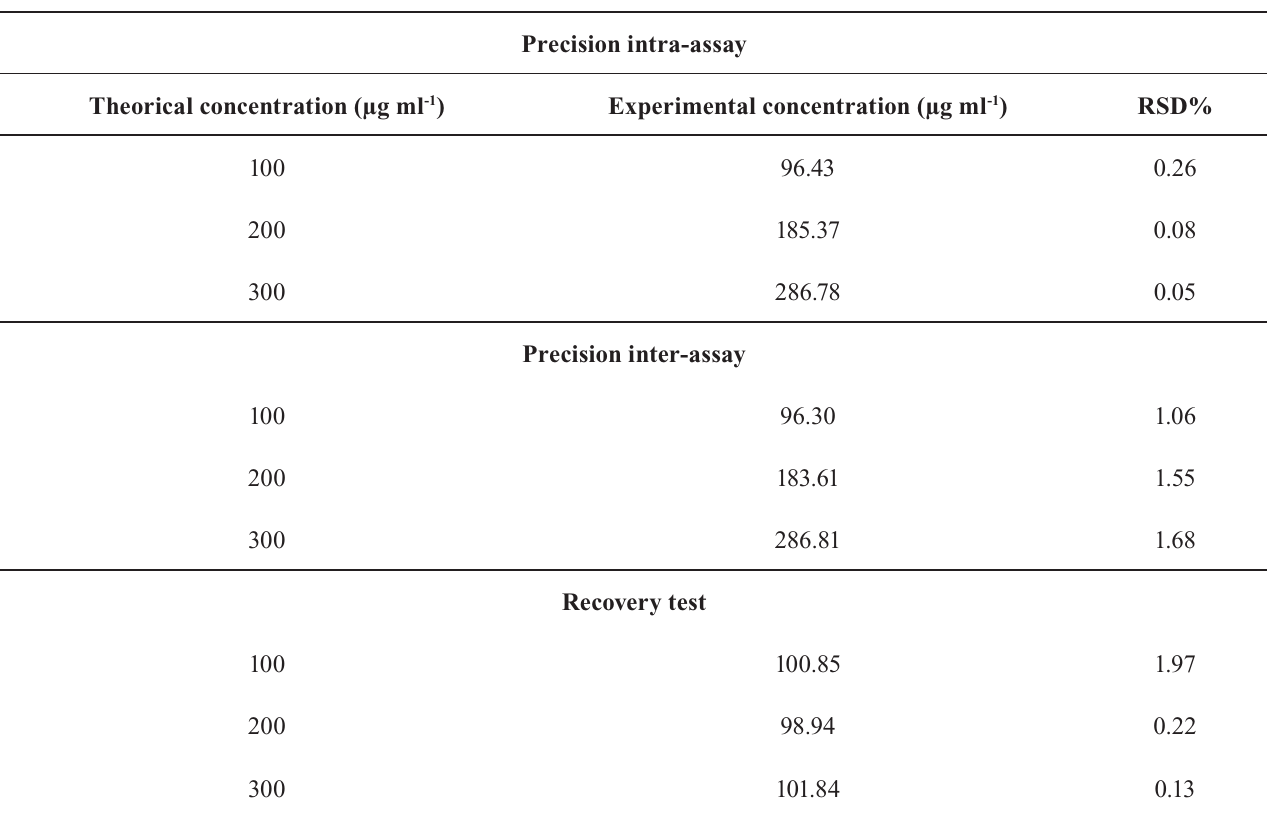
TABLE I - V alidation parameters for CA quantification